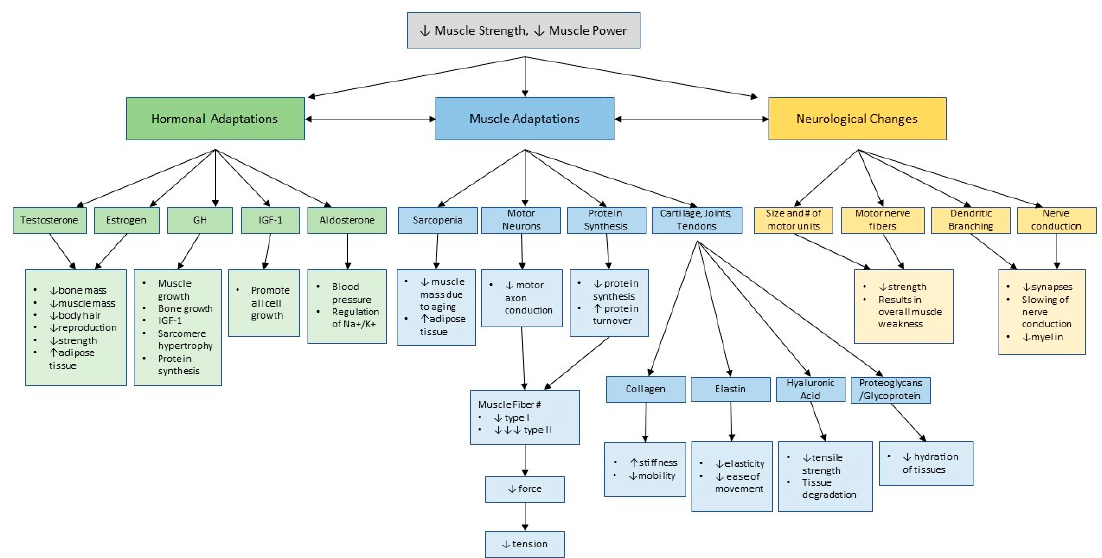
Figure 1. Adaptation of Aging Summary. As displayed, adaptations have been separated into components of hormonal adaptations, muscle adaptations, and neurological adaptations. Hormonal adaptations include changes in testosterone, estrogen, growth hormone (GH), insulin-growth factor 1 (IGF-1), and aldosterone. Muscle adaptations include sarcopenia, changes in motor neurons, changes in protein synthesis capabilities, and changes within cartilage, joints, and tendons. Neurological adaptations include changes in the size and number of motor units, motor nerve fibers, dendritic branching, and nerve conduction. All factors listed under their designated subgroup occur with aging and are interconnected. Information compiled from: [2,3,7,16–20,22].